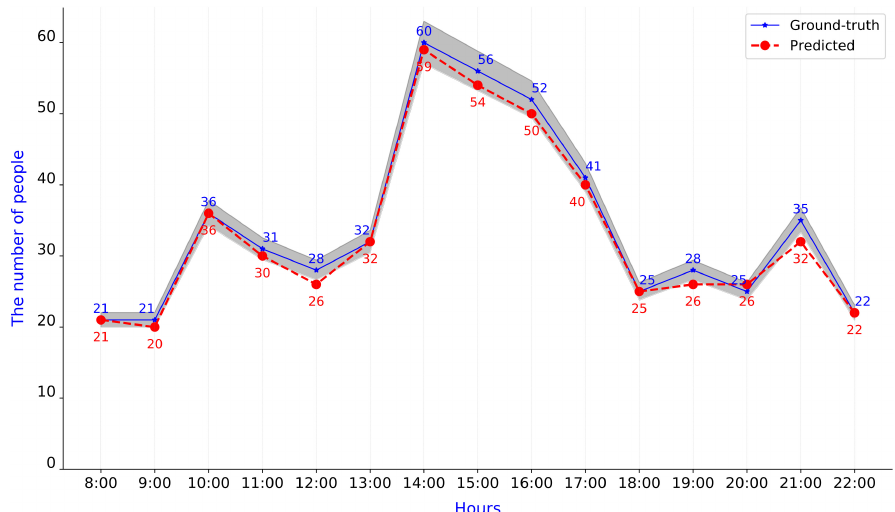
Figure 15. Predicted number of people in reading room following the timeline.